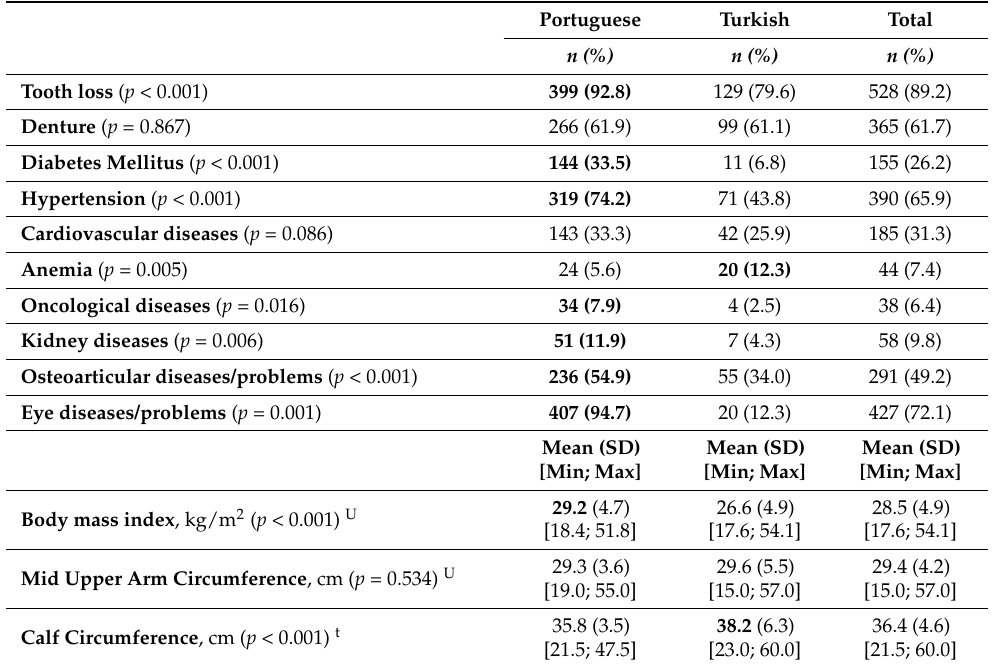
Table 2. Comparisons between Portuguese and Turkish older adults regarding health and anthropo- metric characteristics.